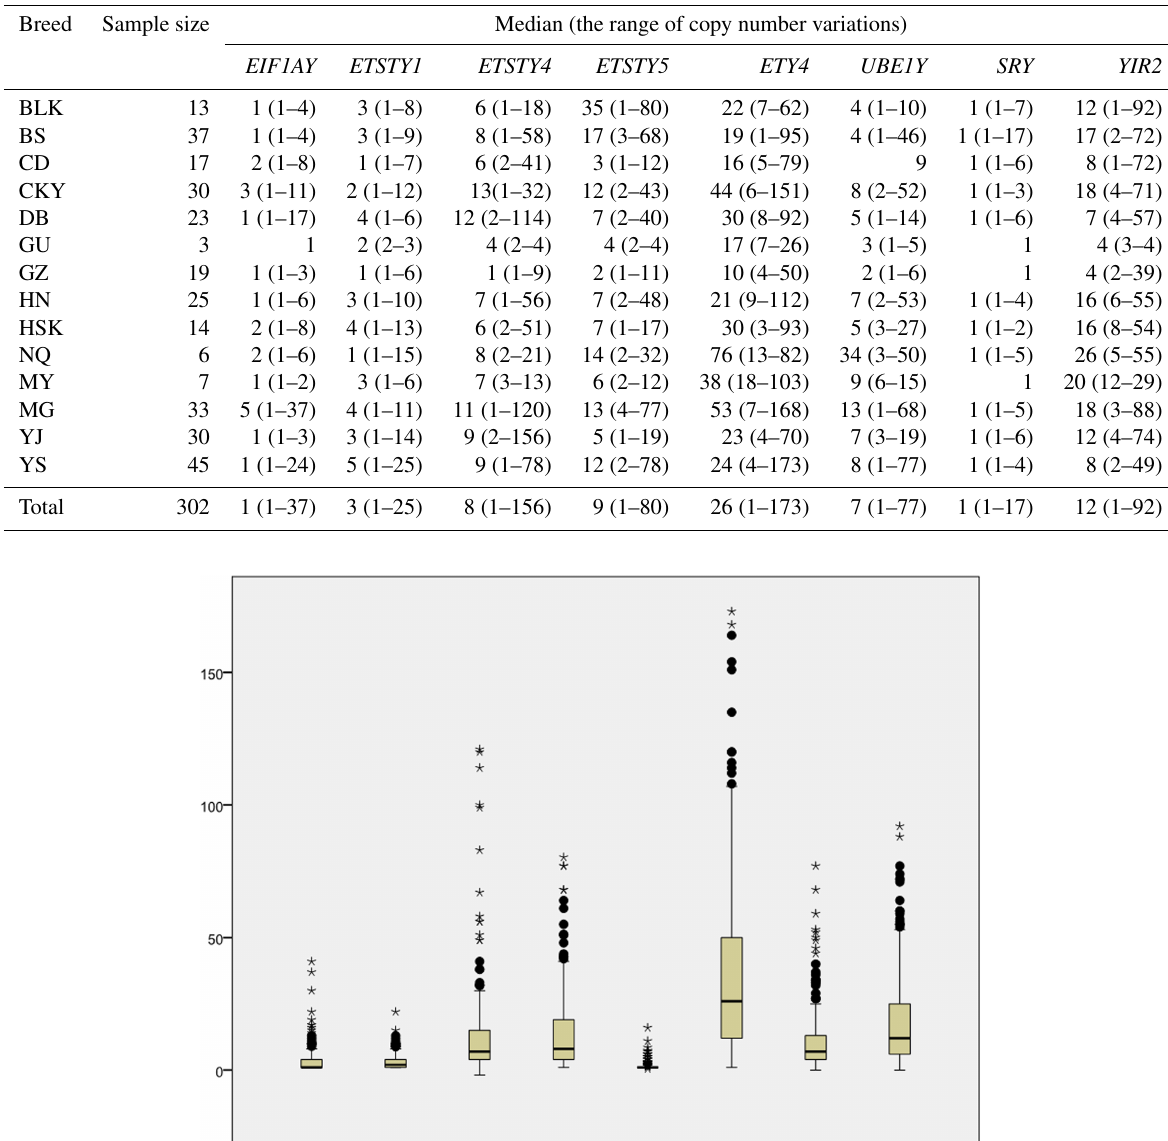
Table 3. Copy number variations of eight Y chromosome genes in horses. Breed